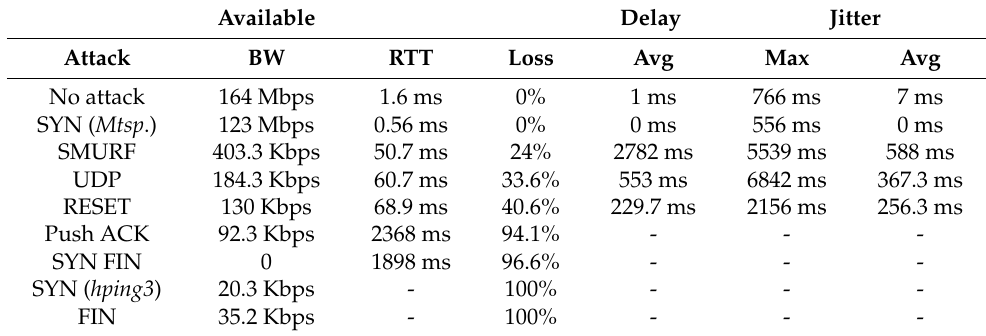
Table 4. DoS Attacks